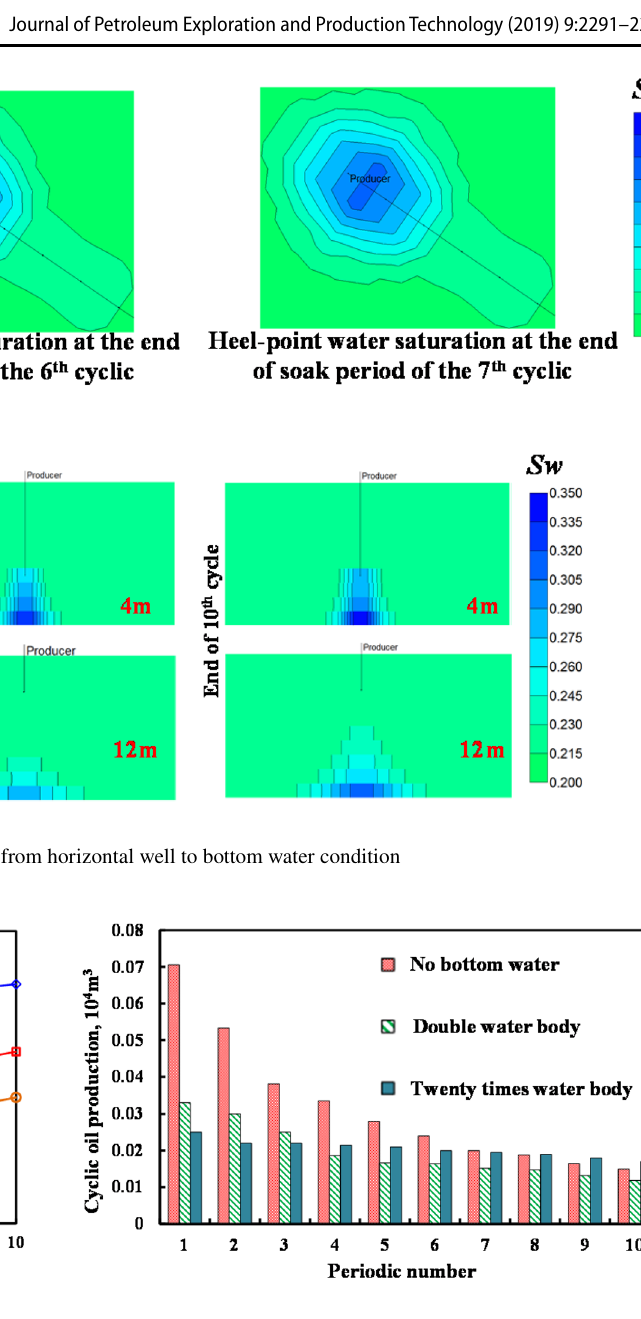
Fig. 8 Effect of bottom water body size on the recovery degree Fig. 9 Effect of bottom water body size on the cyclic oil